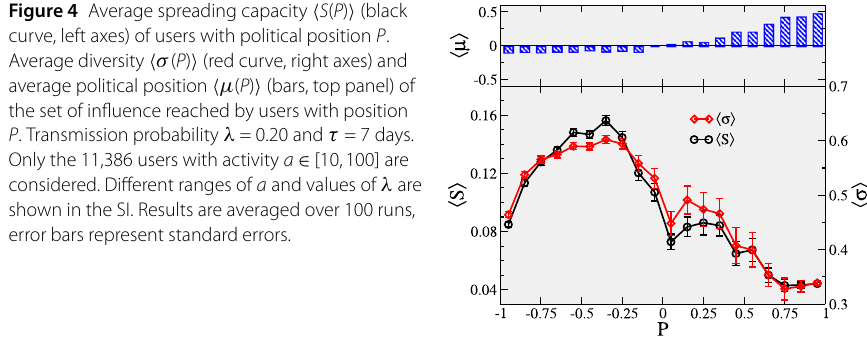
Figure 4 Average spreading capacity (cid:2) S ( P ) (cid:3) (black curve, left axes) of users with political position P . Average diversity (cid:2) σ ( P ) (cid:3) (red curve, right axes) and average political position (cid:2) μ ( P ) (cid:3) (bars, top panel) of the set of influence reached by users with position P . Transmission probability λ = 0.20 and τ = 7 days. Only the 11,386 users with activity a ∈ [10,100] are considered. Different ranges of a and values of λ are shown in the SI. Results are averaged over 100 runs, error bars represent standard